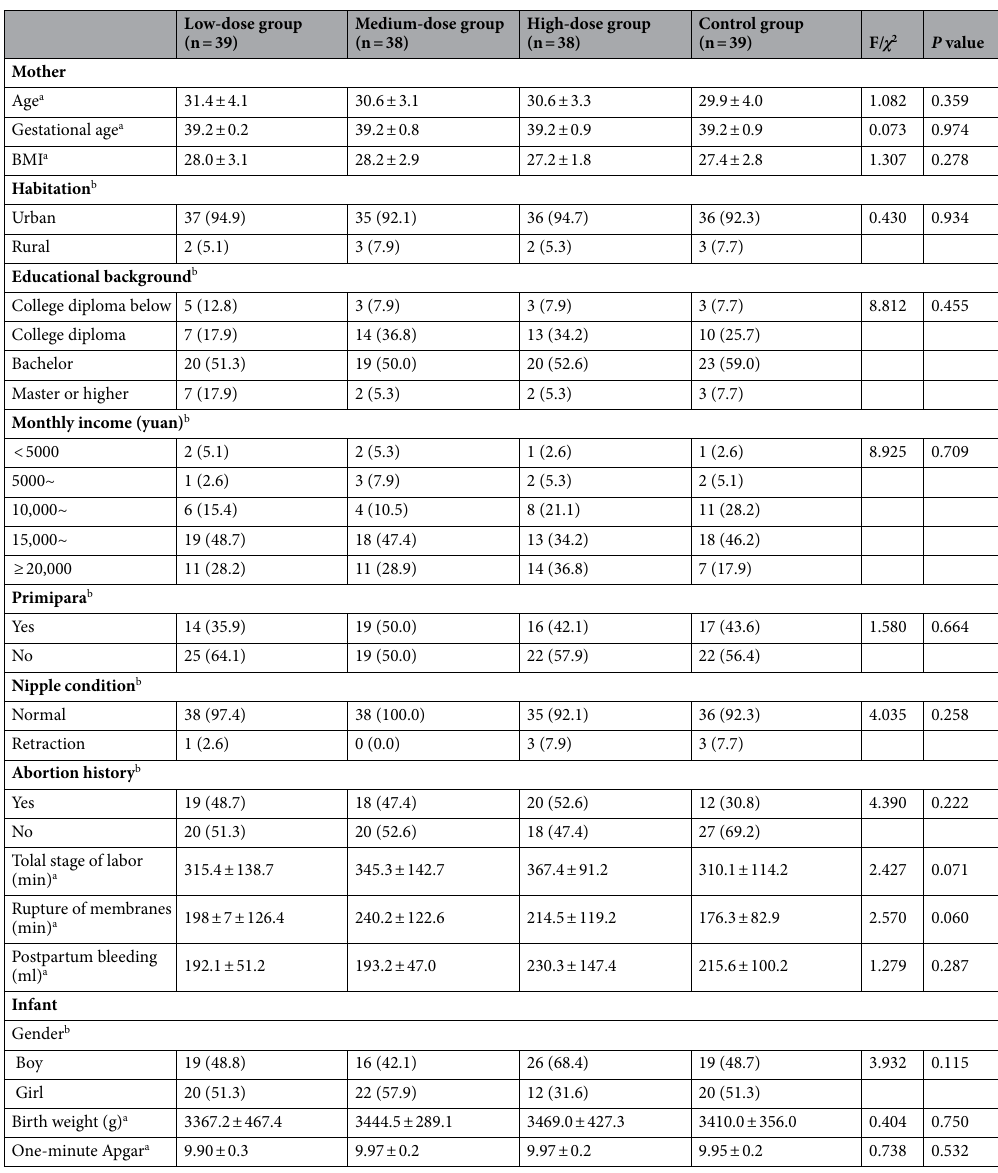
Table 2. Mothers and infants baseline variables. a Mean ± standard deviation. b Frequency, percentage The total stage of labor refers to the entire process from the parturition (regular uterine contractions) to the delivery of the fetus and